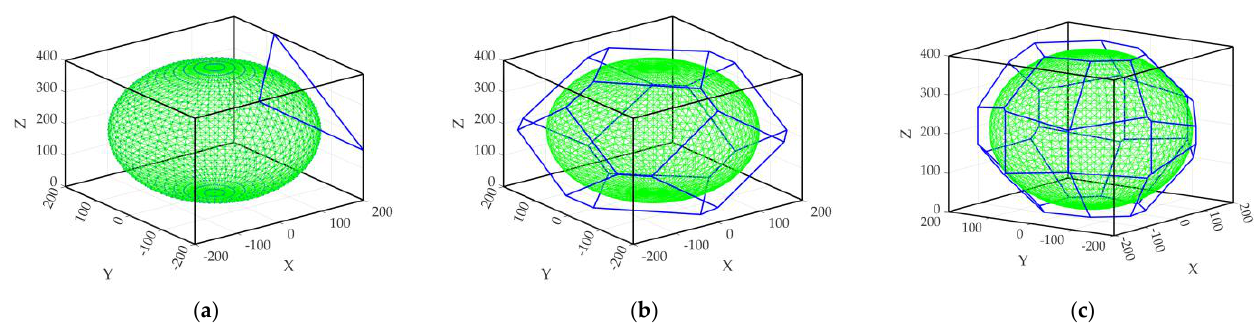
Figure 11. Dynamic reconstruction effect of CPH. ( a ) 1st cutting; ( b ) 8th cutting; ( c ) 19th cutting.